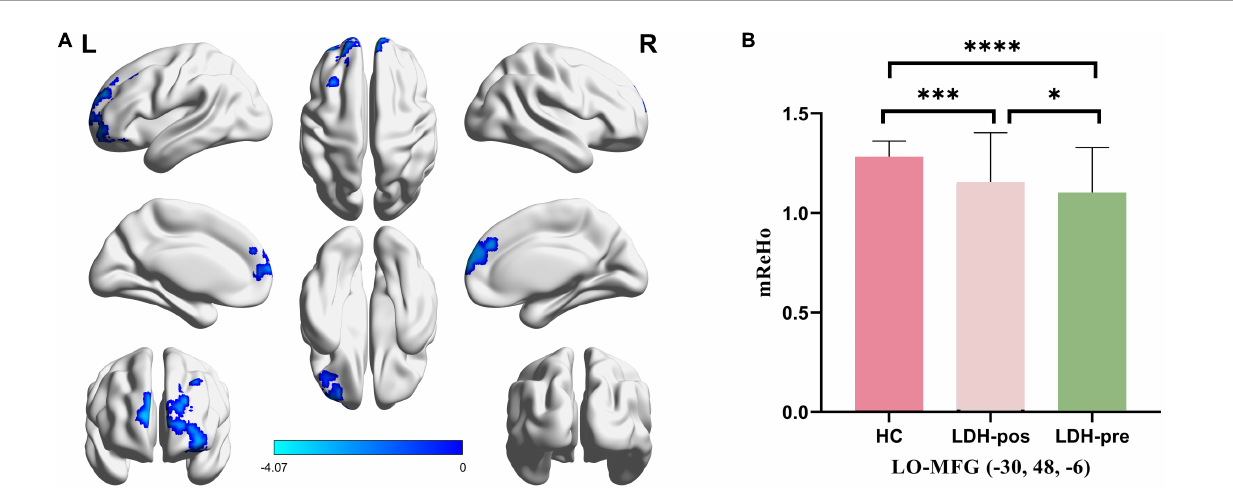
FIGURE2 (A) Significantly different regions in ReHo between LDH-pre patients and HCs. (B) The bar graphs represent the mean ReHo extracted from abnormal clusters. The LDH patients and HCs were compared using two-sample t -tests, and LDH patients before and after Tuina were compared by paired t -tests. ∗ indicated significance level at p < 0.05 (two-tailed), ∗∗∗ indicated significance level at p < 0.001 (two -tailed), ∗∗∗∗ indicated significance level at p < 0.0001 (two -tailed). HC, healthy controls; LDH-pos, LDH patients after Tuina; LDH-pre, LDH patients before Tuina; LO-MFG, left orbital part middle frontal gyrus.